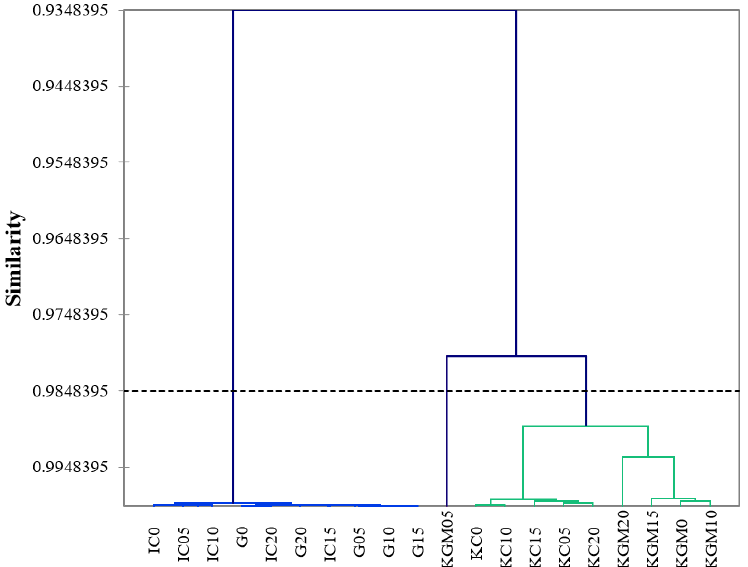
Figure 5. Dendrogram from agglomerative hierarchical cluster analysis (unweighted pair–group average method) of 20 model confectionary gel samples by instrumental measurements. Similarity based on Pearson correlation coefficient. G = gelatin, IC = ι -carrageenan, KC = κ -carrageenan, KGM = konjac glucomannan.